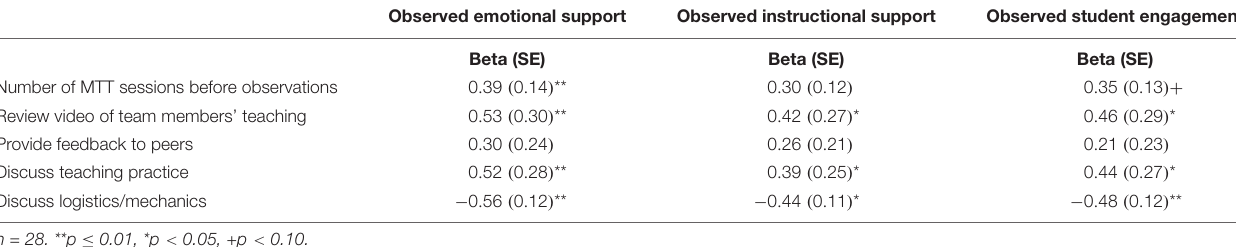
TABLE 6 | Predicting observed classroom experiences with number of MTT sessions and topics discussed in sessions. Observed emotional support